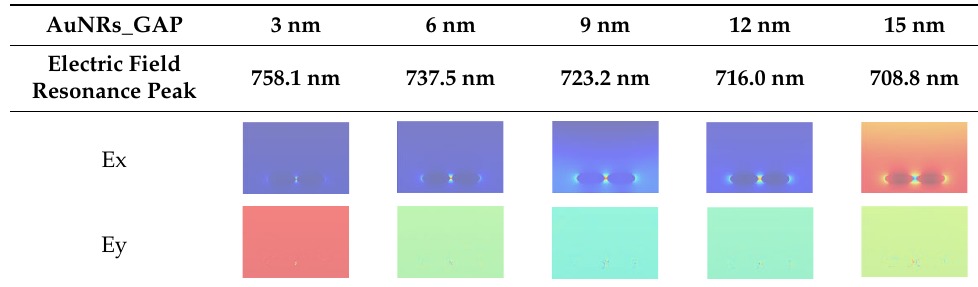
Table 6. Electric field distribution under the resonance peak of the gold nanorod dimer in the longitudinal structure (X-Z section).